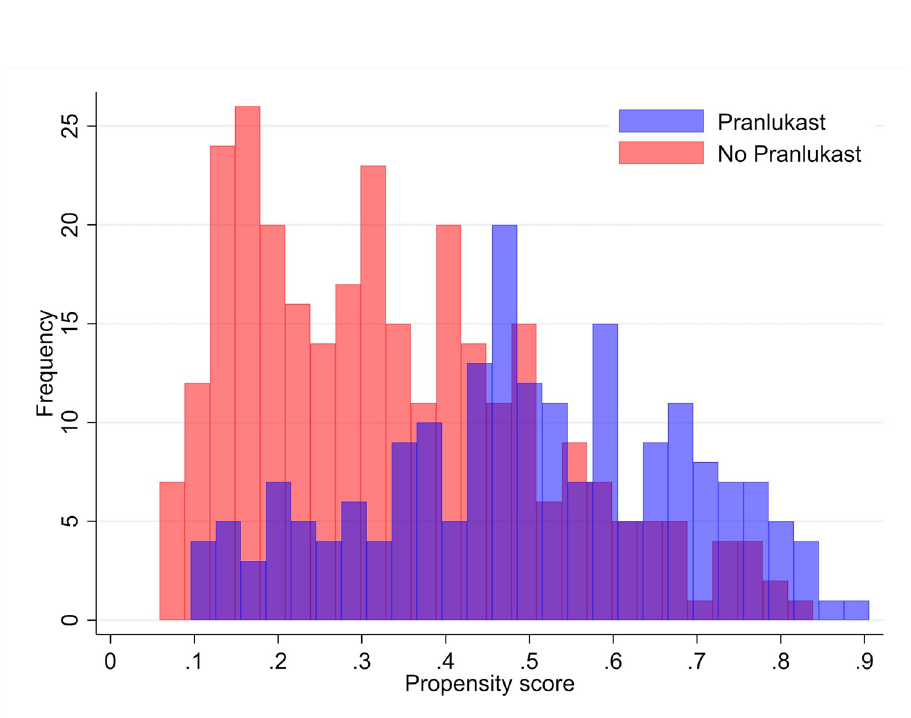
Fig 2. Histogram of propensity score distribution of infants treated with (blue bars) and without (red bars) pranlukast.